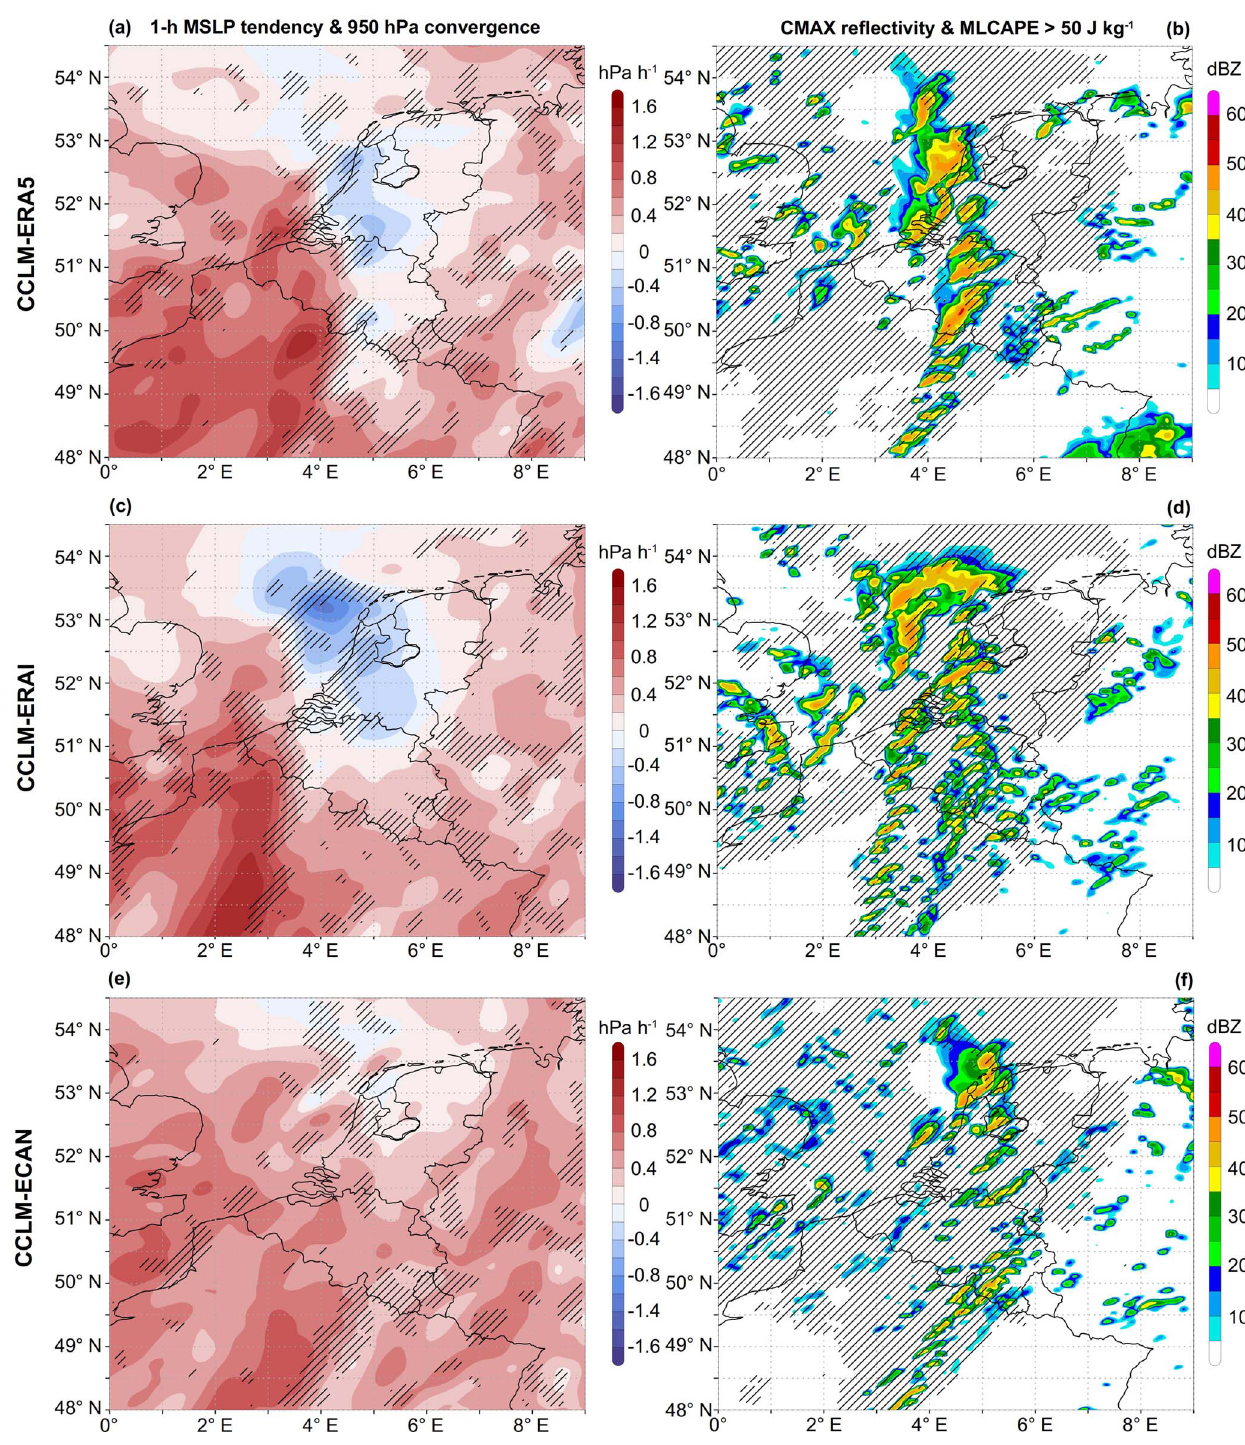
Figure 8. Results from (a, b) CCLM-ERA5, (c, d) CCLM-ERAI and (e, f) CCLM-ECAN at 16:00UTC. (a, c, e) 1-hourly mean sea level pressure (MSLP) tendency (hPah − 1 ; shaded) and 950hPa convergence smaller than − 5 × 10 − 5 s − 1 (hatched areas) from the 7km simulation. (b, d, f) Column maximum reflectivity (dBZ; shaded) and 50hPa mixed-layer CAPE above 50Jkg − 1 (hatched areas) from the 2.8km